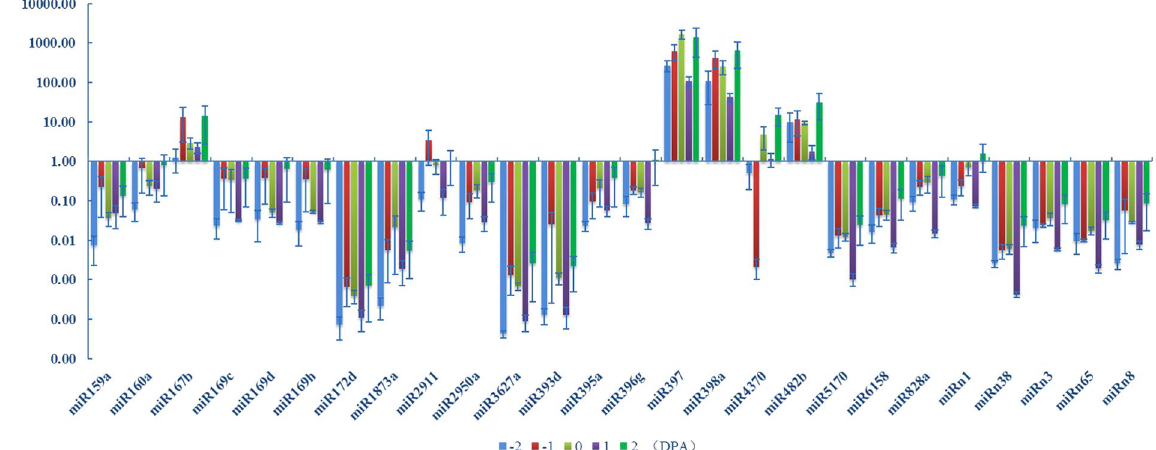
Figure 1. A total of 54 miRNAs were selected and profiled during the cotton fiber initiation and early development. This figure only show the miRNAs with significant expression during fiber initiation in cotton cultivar Xu-142